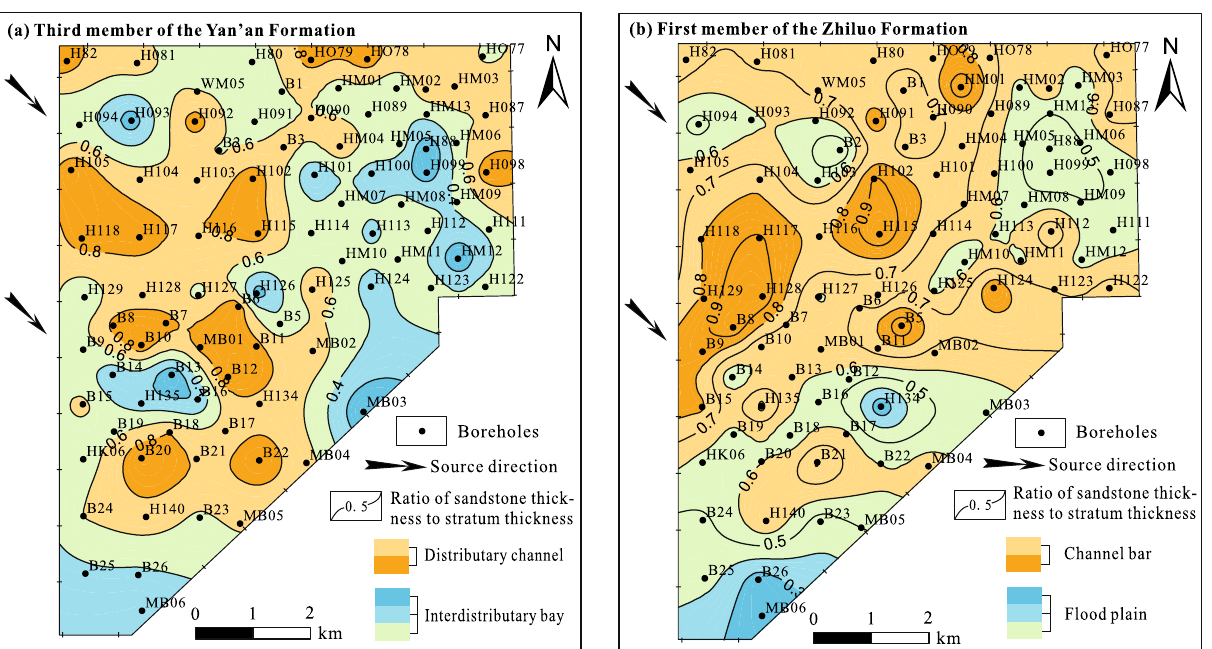
Figure 7. Distribution of sedimentary facies of the Yan’an and Zhiluo